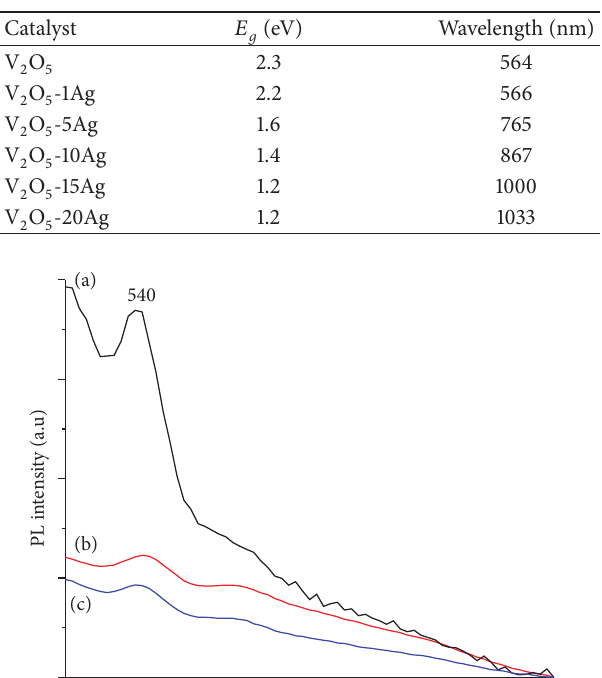
Table 3: Band gap energy ( 𝐸 𝑔 ).